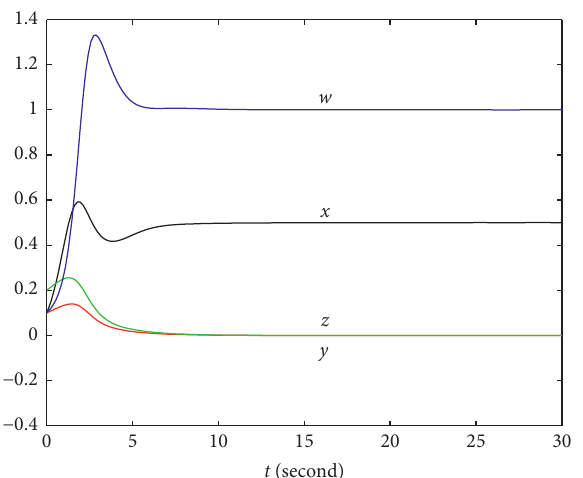
Figure 3: The values a � 2, b � 0.5, c � 0.5, d � 1, e � 2, f � 2, and g � 2 are used. So, we get the stable solution ( x � 0.5, y � 0, z � 0, and w �